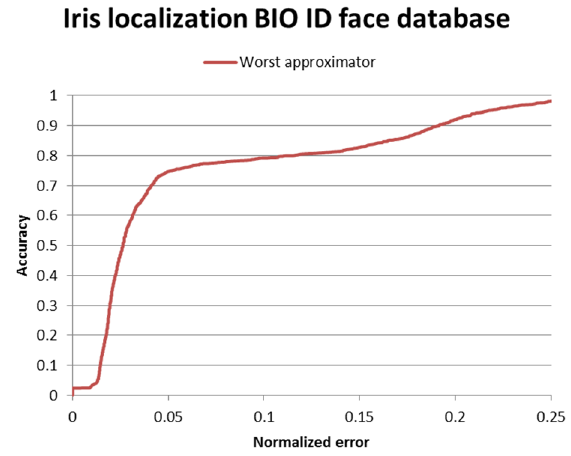
Figure 14. Iris center localization results on the BIO-ID face database.